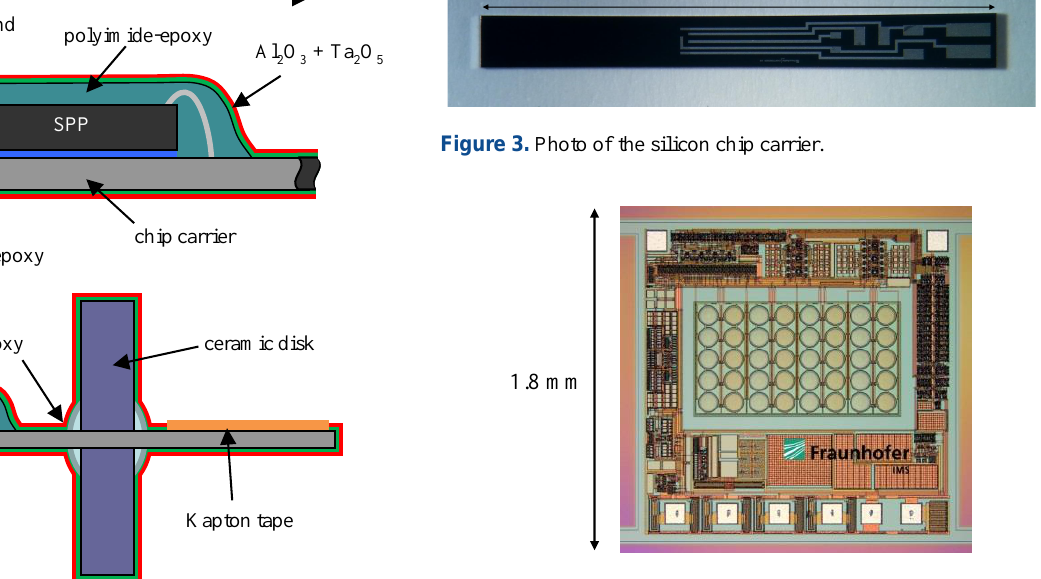
Figure 4. Photograph of the capacitive pressure sensor chip before encapsulation (Betz,